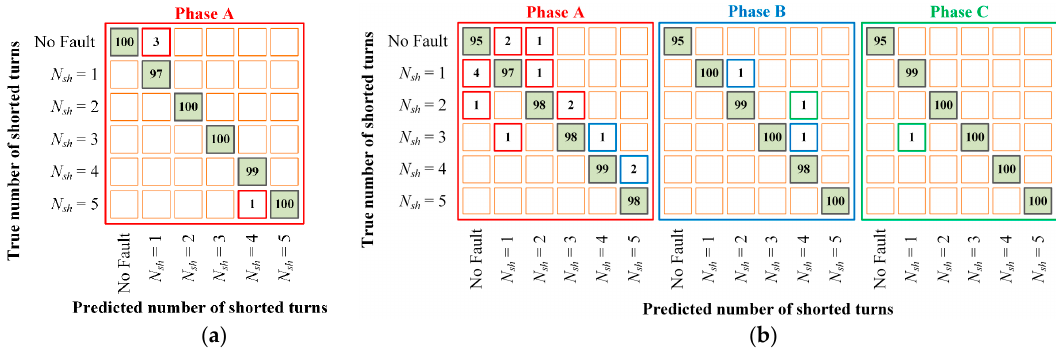
Figure 5. Confusion matrix for testing data: ( a ) CNN-1; ( b ) CNN-2: red envelope—phase A; blue envelope—phase B; green envelope—phase C; N sh —number of shorted turns in stator windings.